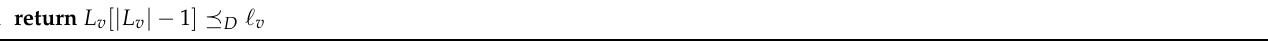
Algorithm 2: BLACK _ BOX _ DOM ( L v , (cid:96) v ) for MD algorithm, d = 2.